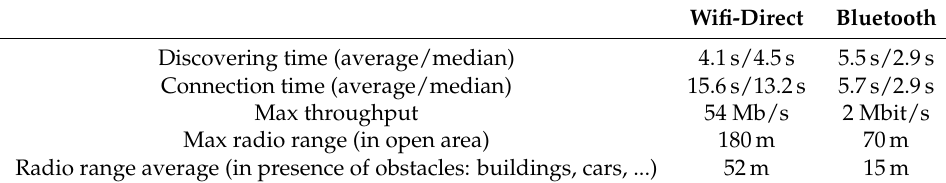
Table 1. Measured performance of Wifi-Direct and Bluetooth using Motorola G4 mobile phones.